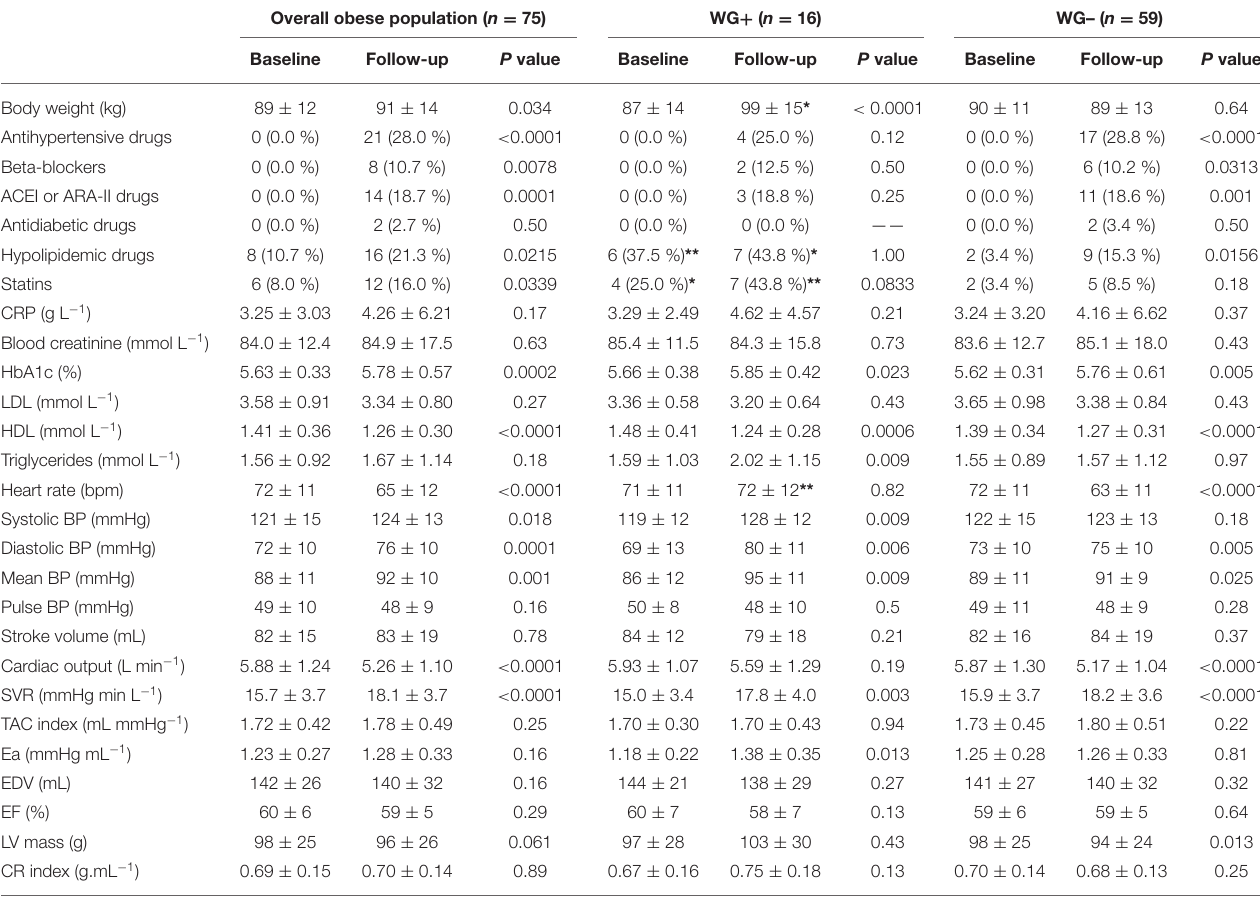
TABLE 2 | Main data collected at baseline and follow-up in the overall obese population, as well as in obese subjects exhibiting significant weight gain (WG + ) or not (WG-), with p values for paired comparisons between baseline and follow-up. Overall obese population ( n = 75) WG + ( n = 16) WG– ( n = 59) Baseline Follow-up P value Baseline Follow-up P value Baseline